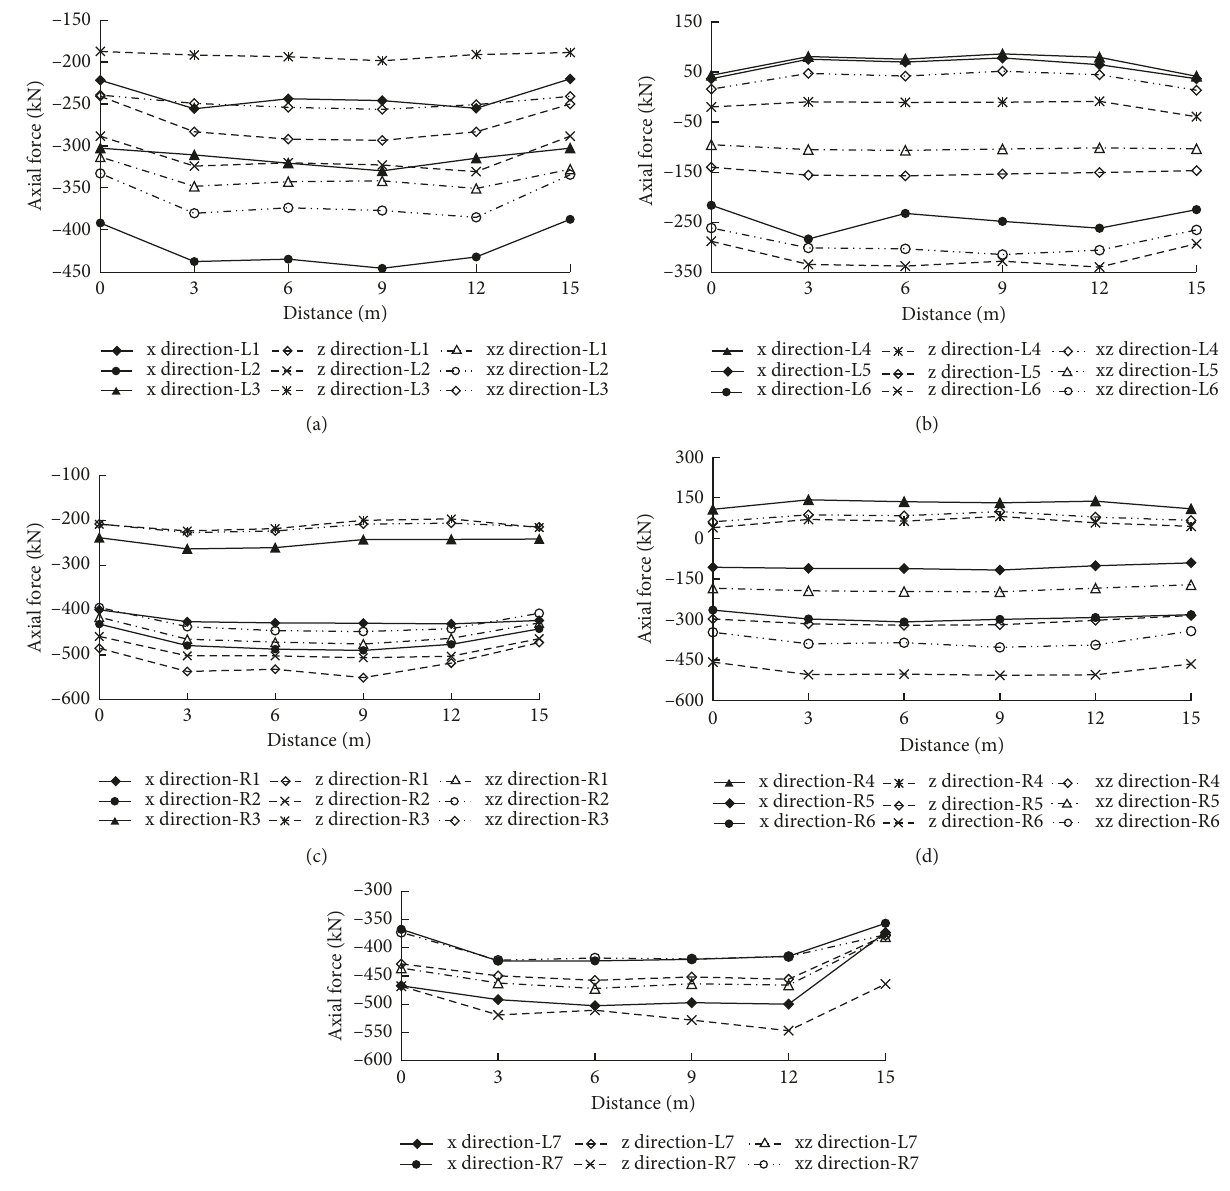
Figure 8: The axial force of tunnel lining along longitudinal foot; the value is 20,204.6 N m for left hole, and 14,117.8 N m wave. In the following paper, the number of measuring · · for right hole. points is L1 ∼ L7 in the left hole and R1 ∼ R7 in the right hole; Under the action of vertical seismic waves, the axial force the detailed measuring points are shown in Figure 6. of left tunnel lining is pressure, the maximum pressure is on Figure 7, under the action of horizontal seismic waves, to the right arch foot, and its value is 458.8 kN. This is different the left tunnel, the vault and right spandrel are tensiled and from the horizontal seismic waves. The change of shear force the others are compressed. The maximum pressure is on the and bending moment is not obvious; the maximum shear right arch foot and its value is 499.3 kN. To the right tunnel, force is 137.7 kN and bending moment is 17,600 N m. To the the vault is tensiled and the others are compressed; the · right hole, the axial force and shear force have similar maximum pressure is on the left arch waist and its value is variation trend as the tunnel lining in the horizontal seismic 488.8 kN. The change of shear force is similar for both wave action. But the bending moment of left arch waist linings, the maximum shear force is on the right arch foot, changes direction and the inside part is changed to the and the value is 151.2 kN for the left hole and 124.3 kN for outside part. The maximum is also on right arch foot and the the right hole. Sign “ ” indicates different direction of force. value is 16,410 N m. The maximum bending moment is also on the right arch − · ±